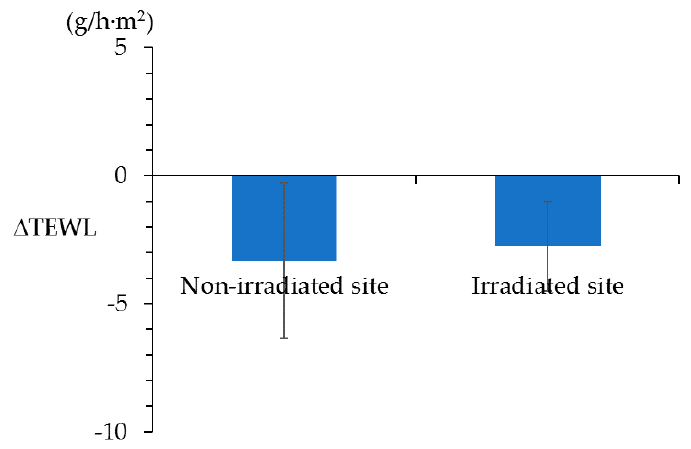
Figure 3. Changes in trans-epidermal water loss (TEWL) at the UVA-irradiated site and non-irradiated site. The results are expressed as ∆ TEWL, which was calculated by subtracting the value of TEWL immediately before irradiation from that a day later, as the mean ± standard deviation of ∆ TEWL of six subjects.